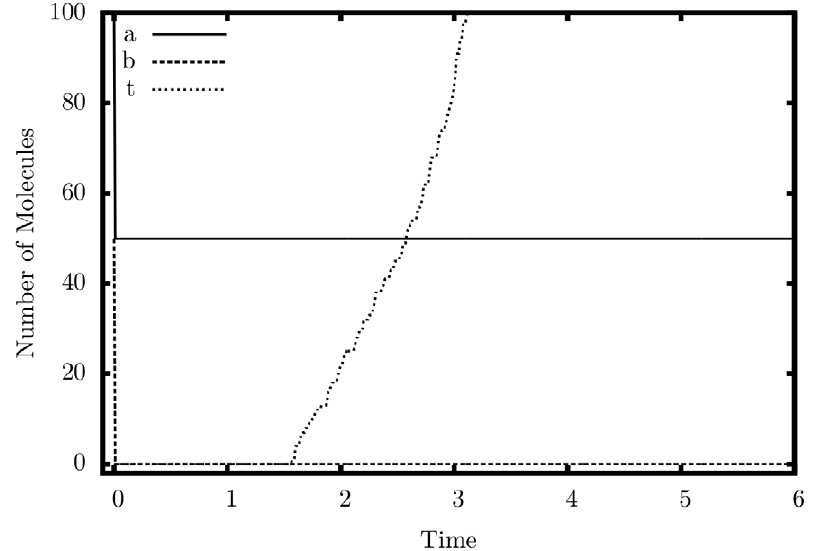
Figure 7. Simulation output of the comparator ( a w b ) construct. a ~ 100 , b ~ 50 .